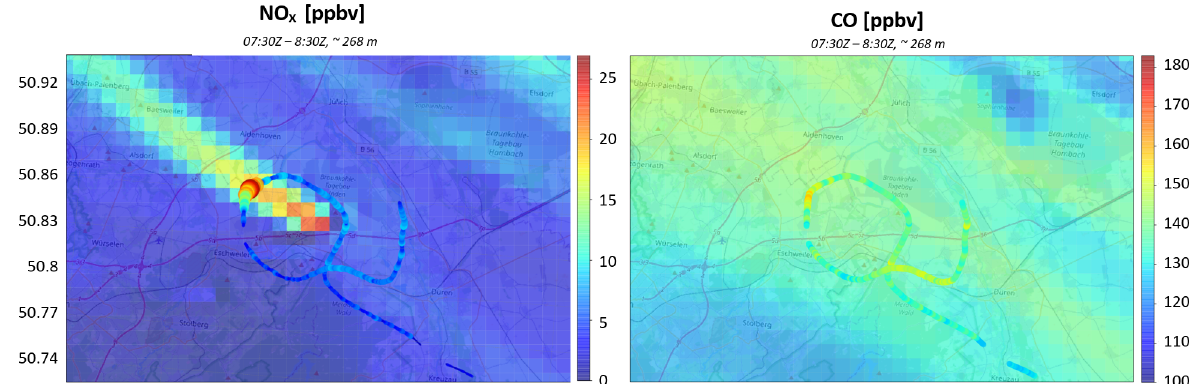
Figure 7. Evolution of industrial plume emissions of NO x and CO based on the EURAD-IM model overlaid by the field-derived Zeppelin